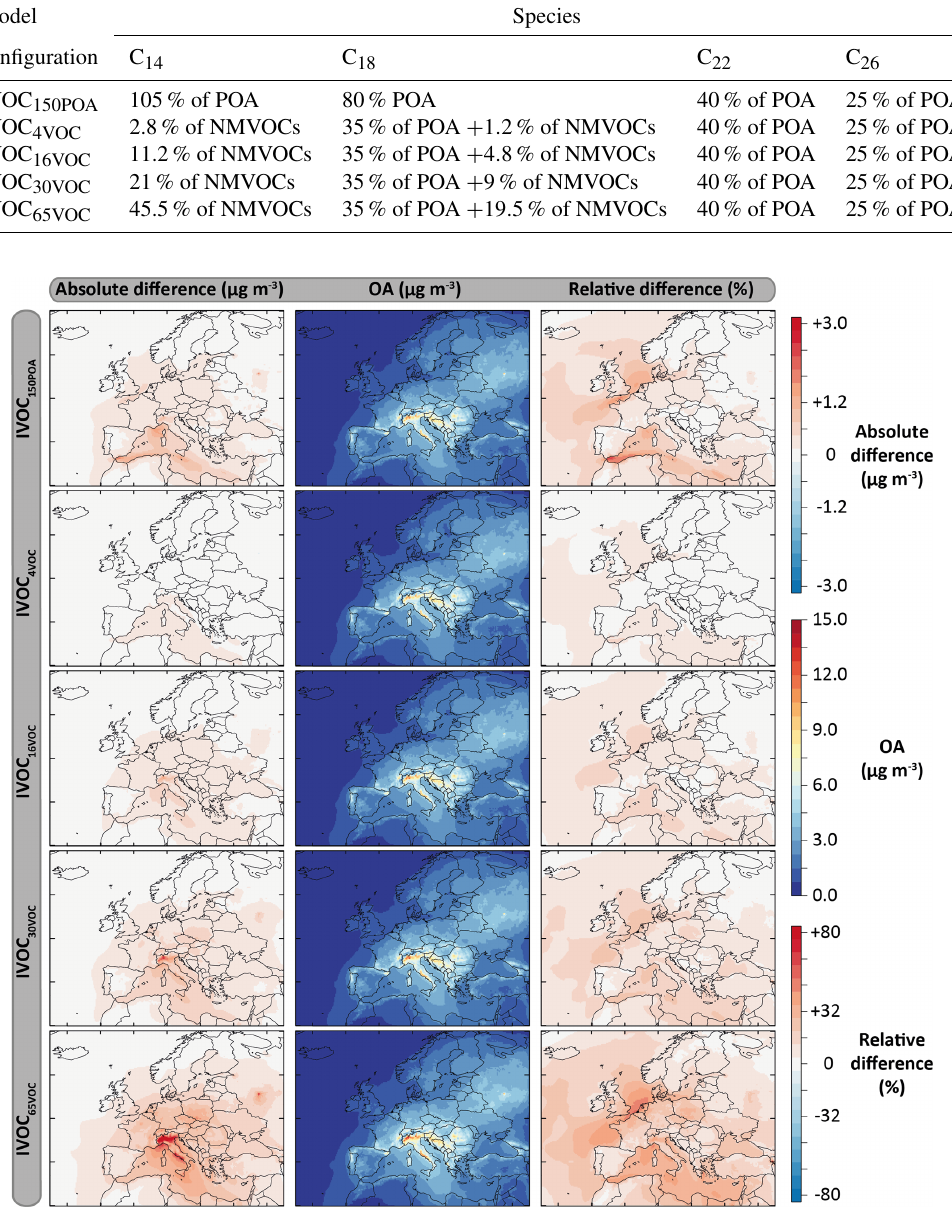
Figure 12. Mean OA mass concentrations simulated with the model configurations including the IVOC emissions for the July–August 2013 period over Europe (second column), and absolute and relative differences with the ref-VBS-GECKO model configurations (left and right columns, respectively). Results are given for the following model configurations: IVOC 150POA (first row), IVOC 4VOC (second row), IVOC 16VOC (third row), IVOC 30VOC (fourth row) and IVOC 65VOC (fifth